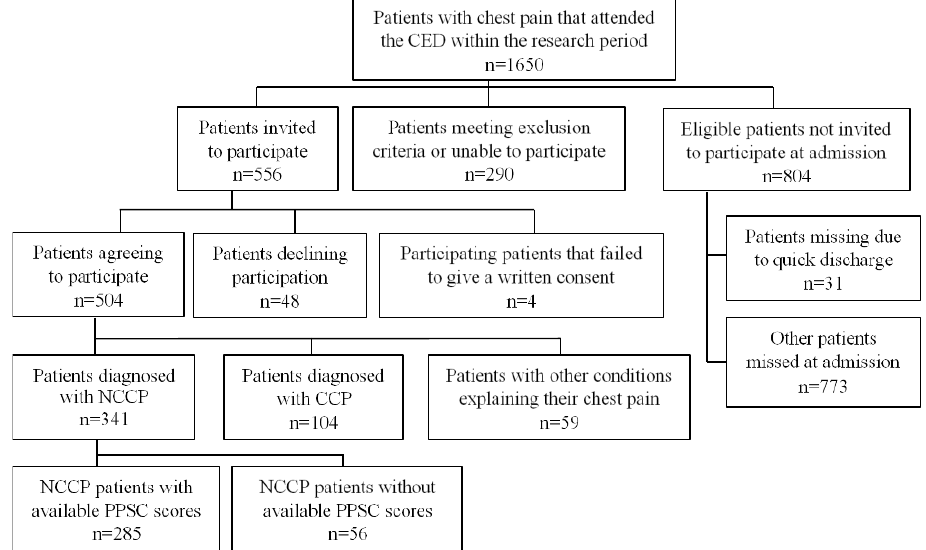
Figure 1. Flow chart of participant selection from patients attending the CED. Note. CED = Cardiac emergency department; NCCP = Non cardiac chest pain; CCP = Cardiac Chest Pain; PPSC = Persistent Physical Symptom Checklist.